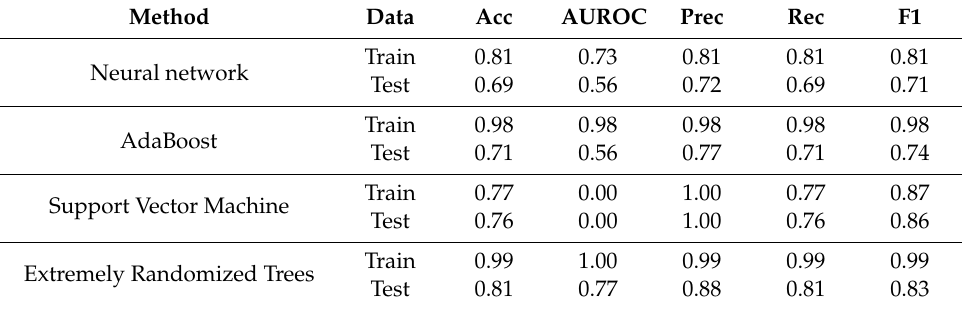
Table 1. ML results in the training and testing sets using 5 di ff erent algorithms and evaluated using the metrics accuracy (Acc), AUROC, precision (Prec), recall (Rec) and F1-score (F1).